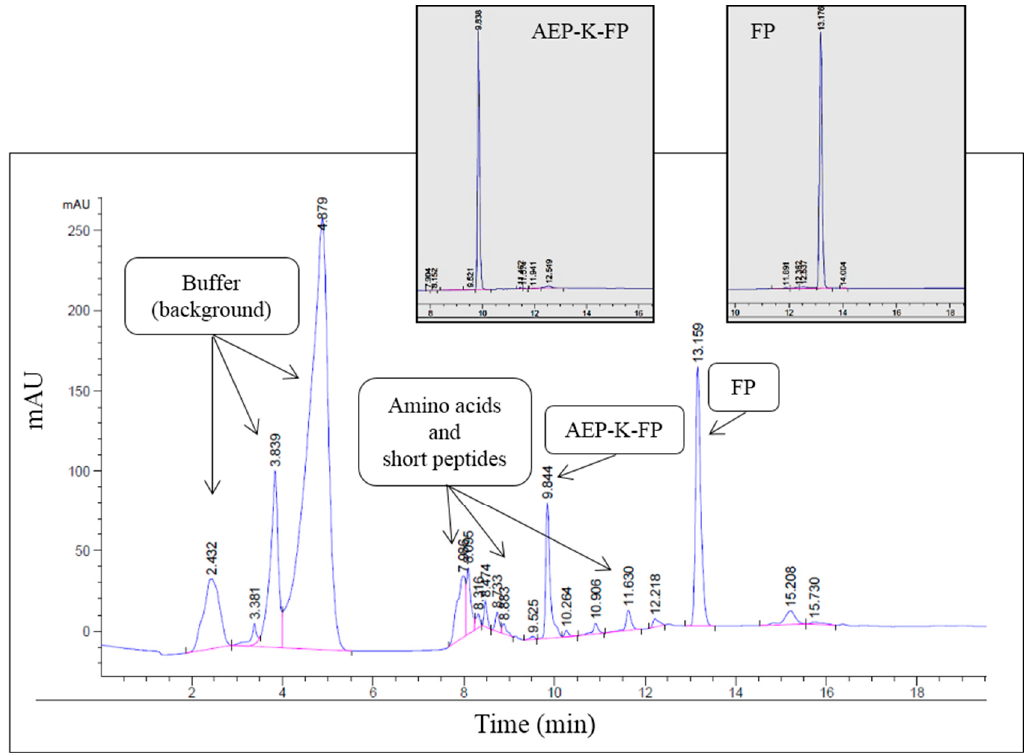
Figure 8. HPLC analysis of AEP-K-FP. The inserts show the elution of the initial AEP-K-FP and free FP. Table 2. Quantification of γ -secretase enzyme after exposure to free FP and AEP-K-FP.